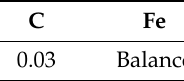
Table 1. Element composition and content of SS316L